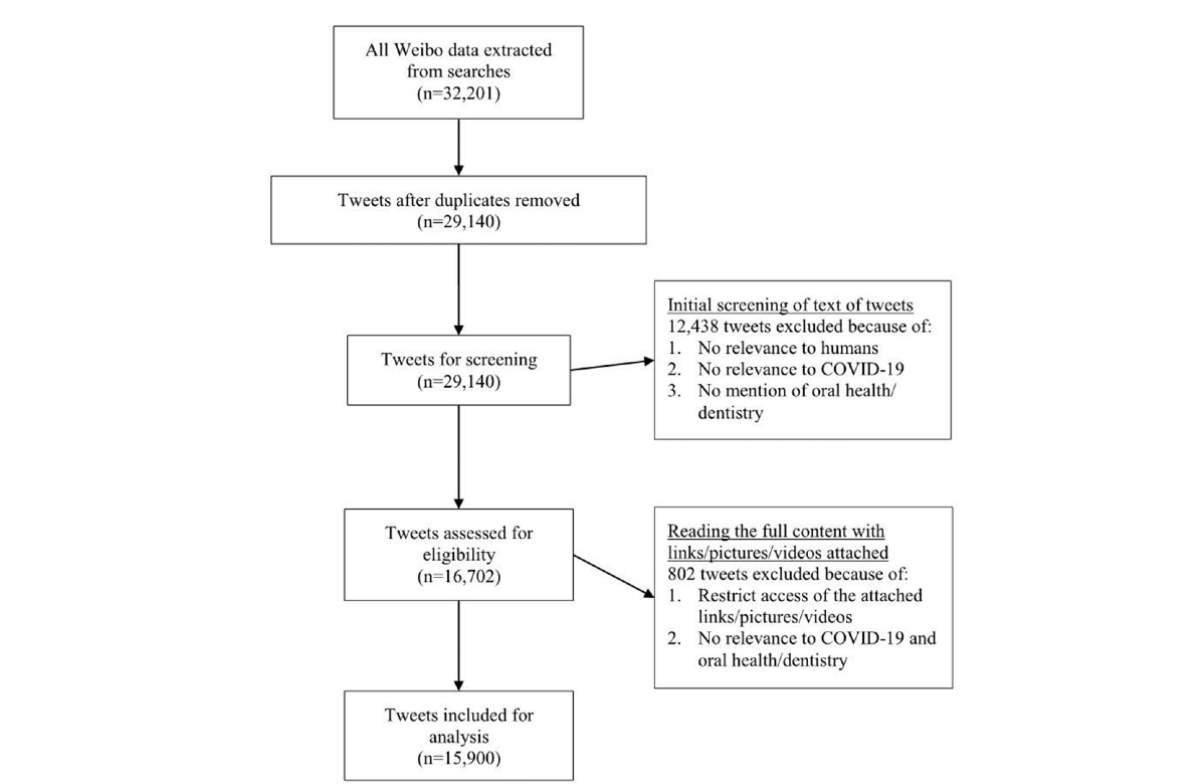
Figure 1. Flow chart of the study. COVID-19: coronavirus